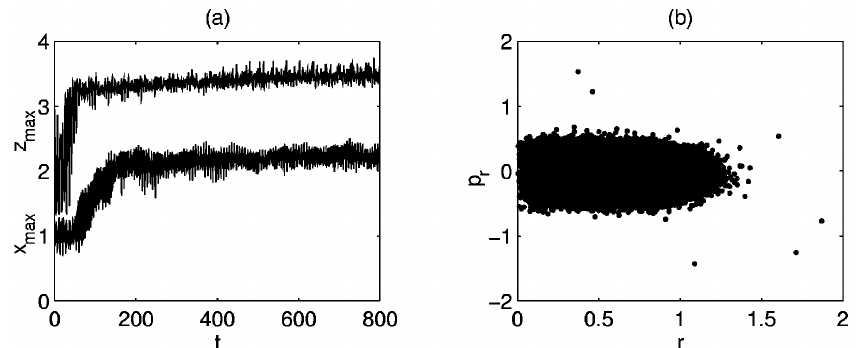
FIG. 17. Coupling effect for the 6D stationary distribution with zero transverse mismatch m (cid:120) (cid:173) m (cid:121) (cid:173) (cid:49)(cid:46)(cid:48)(cid:44) m (cid:122) (cid:173) (cid:49)(cid:46)(cid:53) ( (cid:99) (cid:121) (cid:97) (cid:173) (cid:50)(cid:44) h (cid:120) (cid:173) (cid:48)(cid:46)(cid:53)(cid:53)(cid:44) h (cid:122) (cid:173) (cid:48)(cid:46)(cid:52)(cid:53) ): (a) maximum (cid:120) and (cid:122) and (b) (cid:114) (cid:45) (cid:112) (cid:114) diagram at (cid:116) (cid:173) (cid:56)(cid:48)(cid:48) for particles with the angular momentum j (cid:76) j , (cid:48)(cid:46)(cid:49) (with 25000 particles plotted). (cid:122)